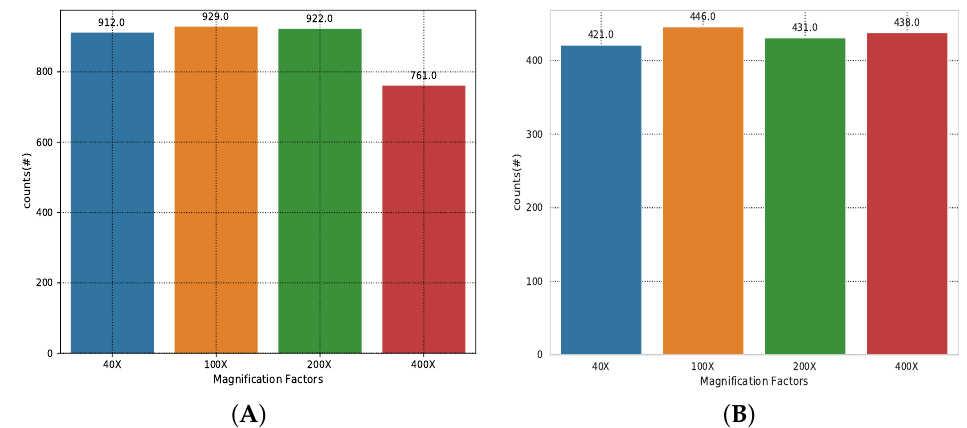
Figure 8. Number of magnification factors in the training and testing datesets. ( A ) Training dataset. ( B ) Testing dataset.